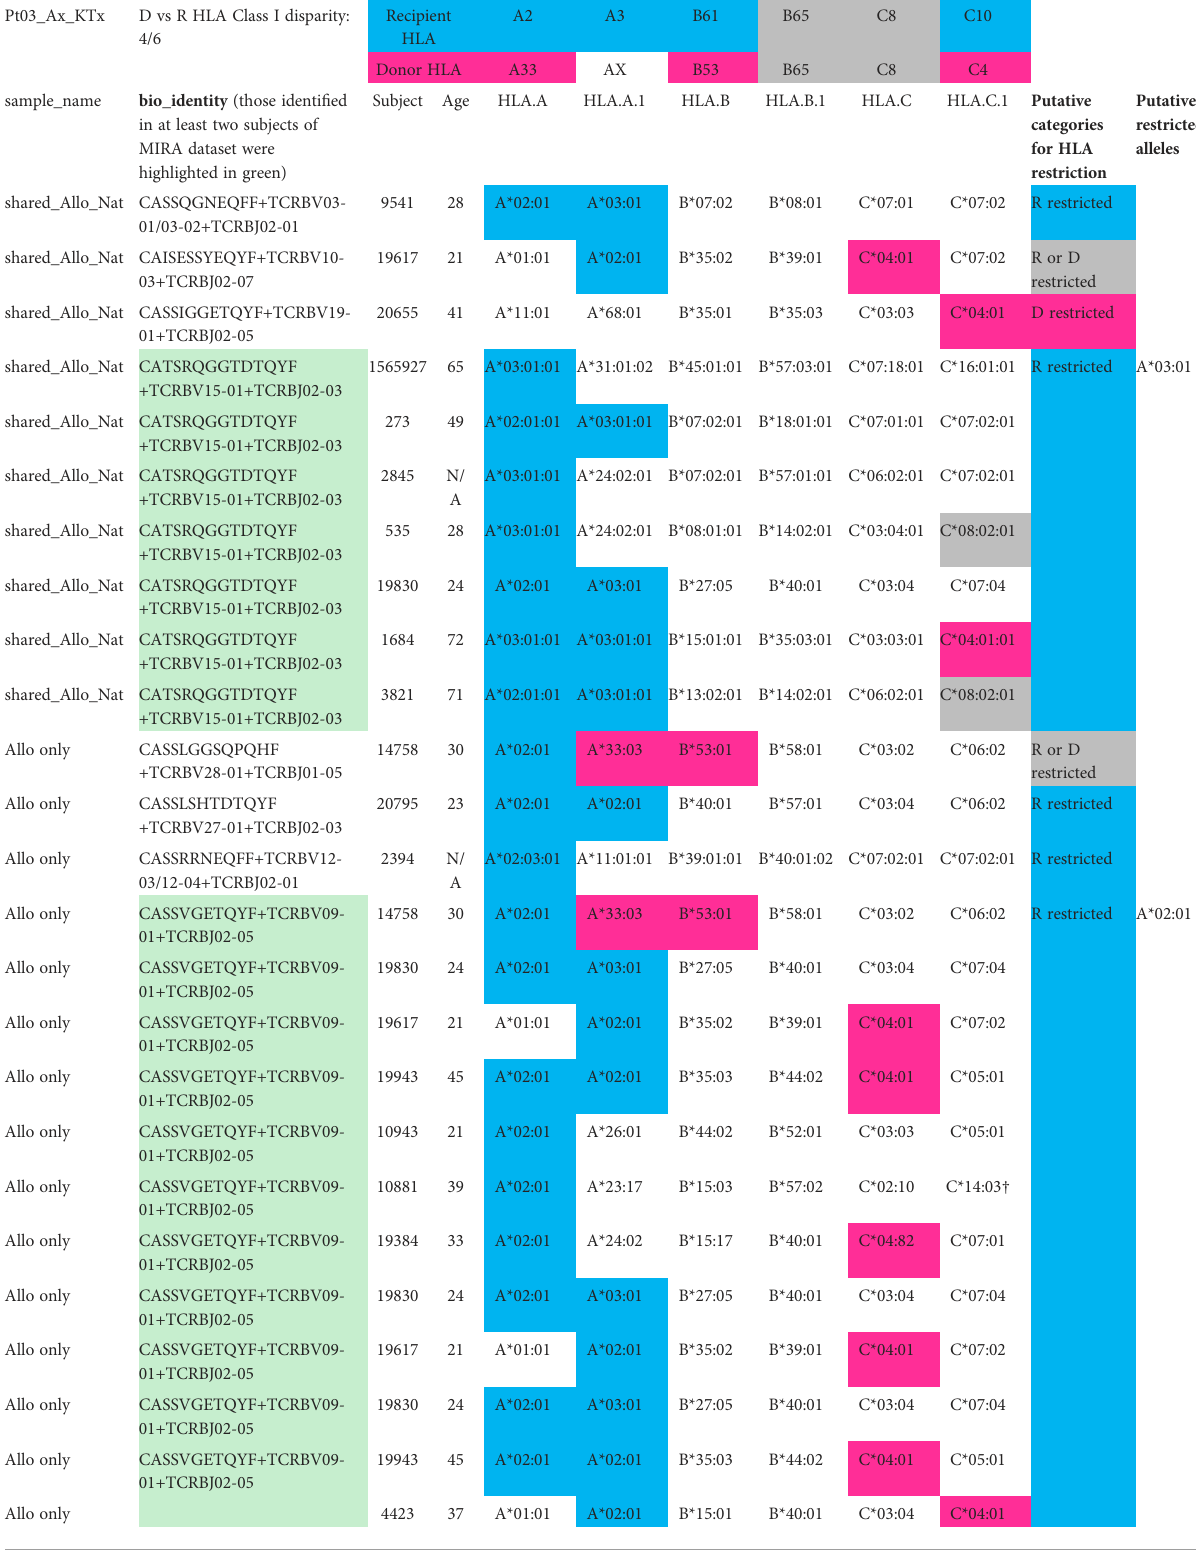
TABLE 3 HLA restriction analysis of SARS-CoV2-speci fi c TCRs identi fi ed by immuneCODE MIRA database in Pt03 as a representative example. Incomplete list of TCRs. For complete list see Supplemental Table 1